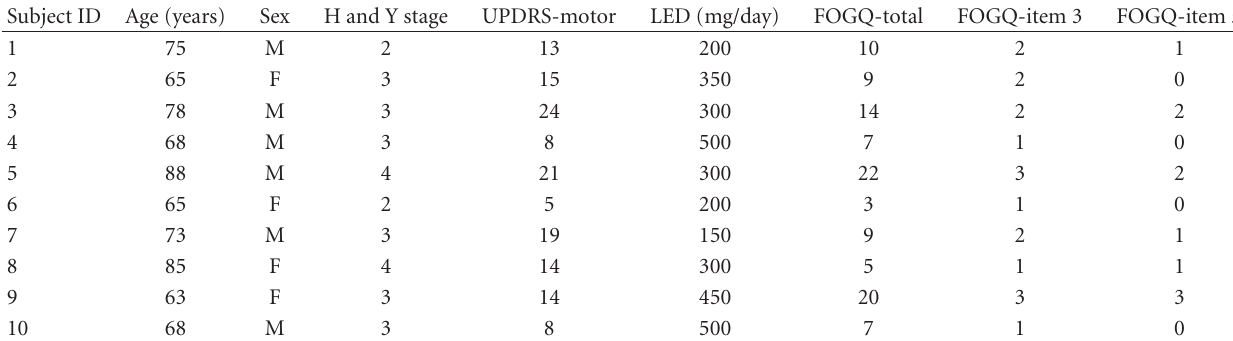
Table 1: Characteristics of PD patients.